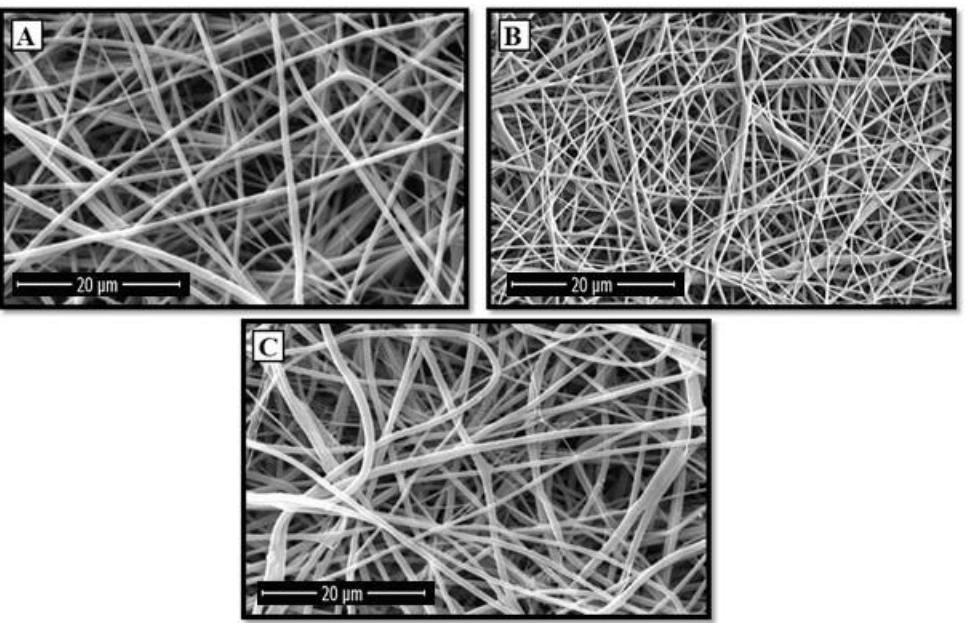
Figure 1. FESEM micrographs of the prepared PCL / Ge nanofibers containing ( A ) 0%, ( B ) 1%, and ( C ) 3 wt.% forsterite nanoparticles.